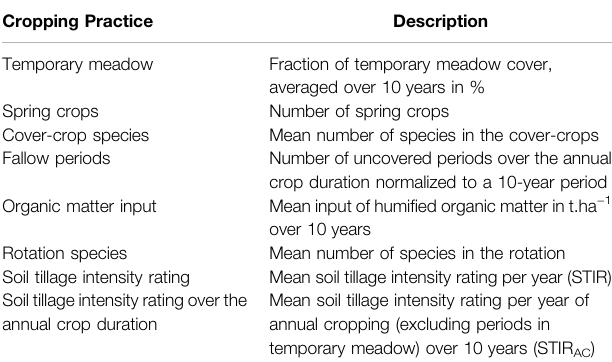
TABLE 2 | Main cropping practices considered in the study. Cropping Practice